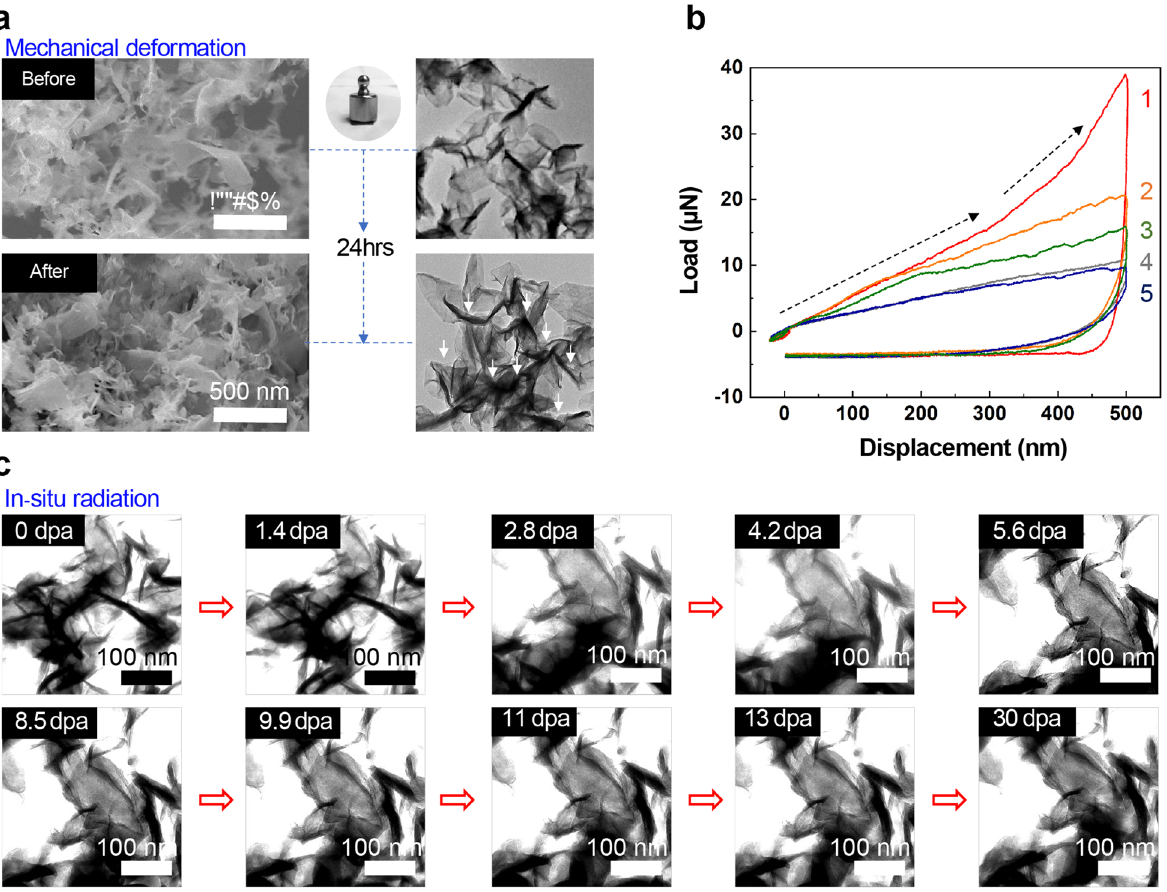
Fig. 5 Mechanically robust, protonically tolerant, and chemically resilient nature of MoS2 3D/3D homostructures. Representative SEM and TEM (inset) images demonstrate the mechanically robust nature of a MoS 2 3D/3D homostructures by virtue of the increasing numbers of elastic buckling of extremely thin edges (arrows in white color) after subjected to an external load for 24 h. b Load/displacement curves of fi ve cycles of compression and release on MoS 2 3D/3D homostructures show the initially elastic response to displacement of 300 nm at an external load of 17 µ N. c A series of still frames derived from continuous TEM imaging under an in-situ 46 keV Au + reveals the high radiation tolerance of MoS 2 3D/3D